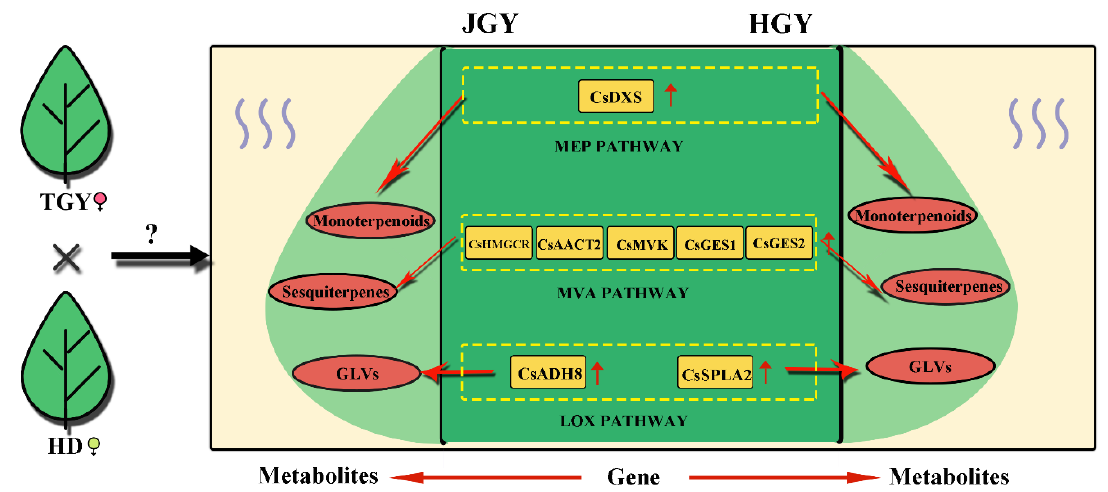
Figure 9. Schematic diagram of key genes and metabolites of terpenoid and green leaf volatiles in F1 generation (HGY and JGY). Yellow square indicates gene with higher expression level in F1 generation than in parental line; Red oval indicates metabolite with higher content in F1 generation than in parental line. Solid line represents direct action.